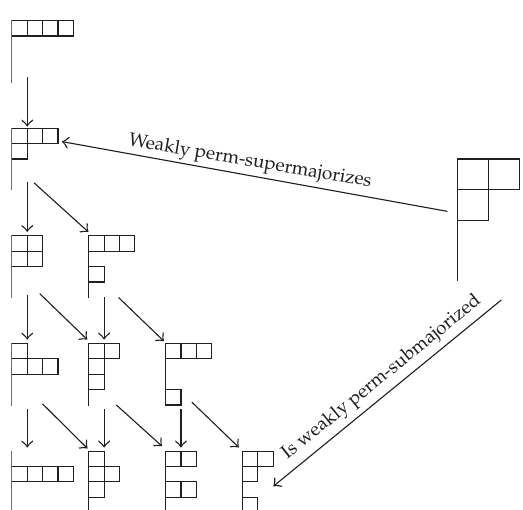
Figure 6: An example for the algorithms 4 and